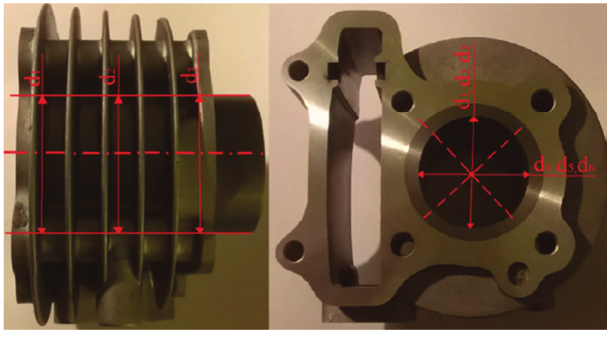
Fig. 7. Localization of measurement points for cylinders Each measurement was repeated three time and on the basis of this arithmetic mean was calculated. The results of measurement and calculation were presented in Table 3 and diameter’s differences in Table